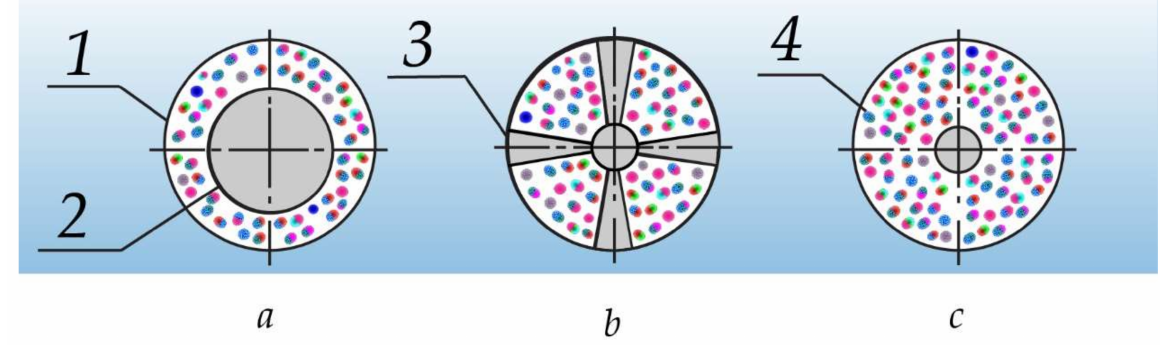
Figure 6. Structure diagrams of devices made of various weights nanoparticles, in the form of ( a )—washers with an inner hole; ( b , c )—spherical shape with diffusers and nanoparticles; 1 and 2—outer and inner shell; 3—diffuser holes;